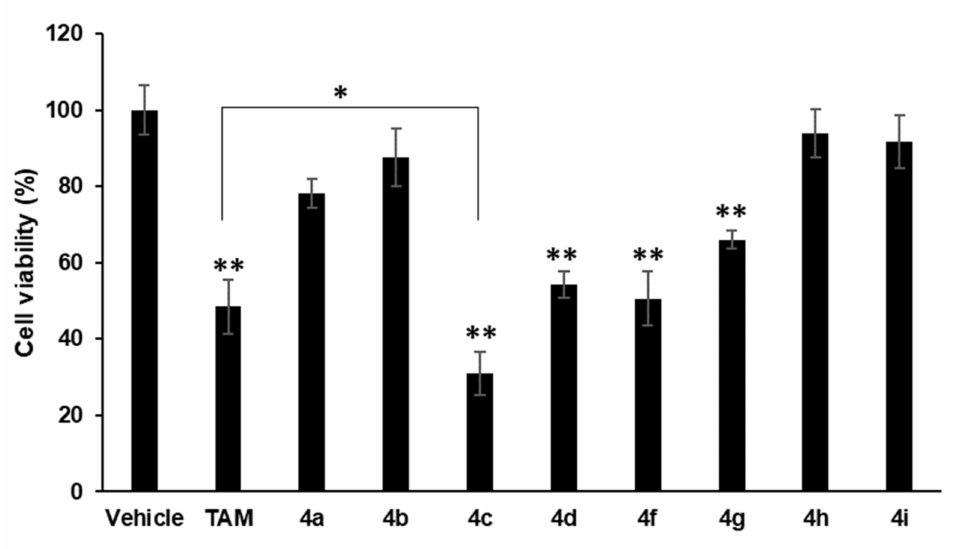
Figure 2. Cell viability of MCF7 cell-generated spheroids after culture in 3D Matrigel for 10 days. Preformed MCF7 cell-generated spheroids were treated with compounds for 72 h before assessing cell viability. A concentration of 5 µ M was used for the treatment. The cell viability of the MCF7 cell-generated spheroids was evaluated using an AlamarBlue ® viability assay as described in the Materials and Methods section. Bars are the mean of triplicate experiments; bars, ± SD. ** P < 0.001, * P < 0.05.